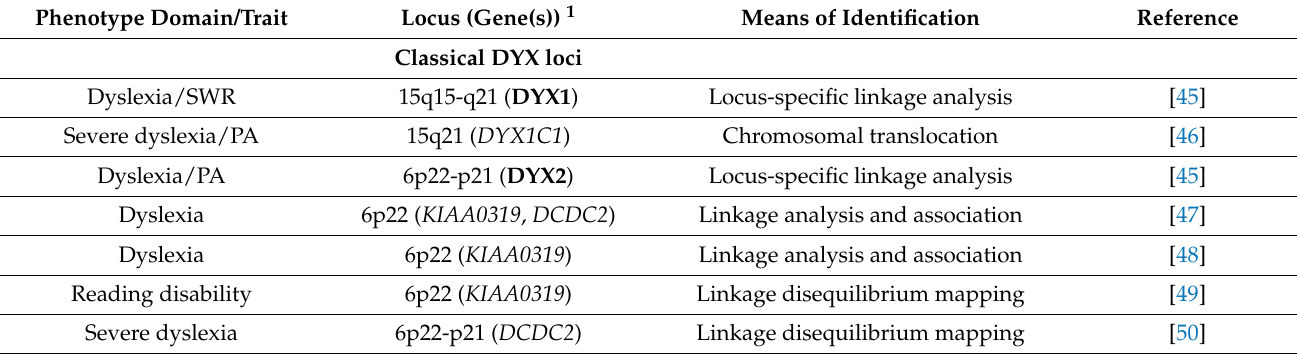
Table 1. Earlier studies (1993–2013) presenting evidence for association of genomic loci with SLD and/or related traits. Phenotype